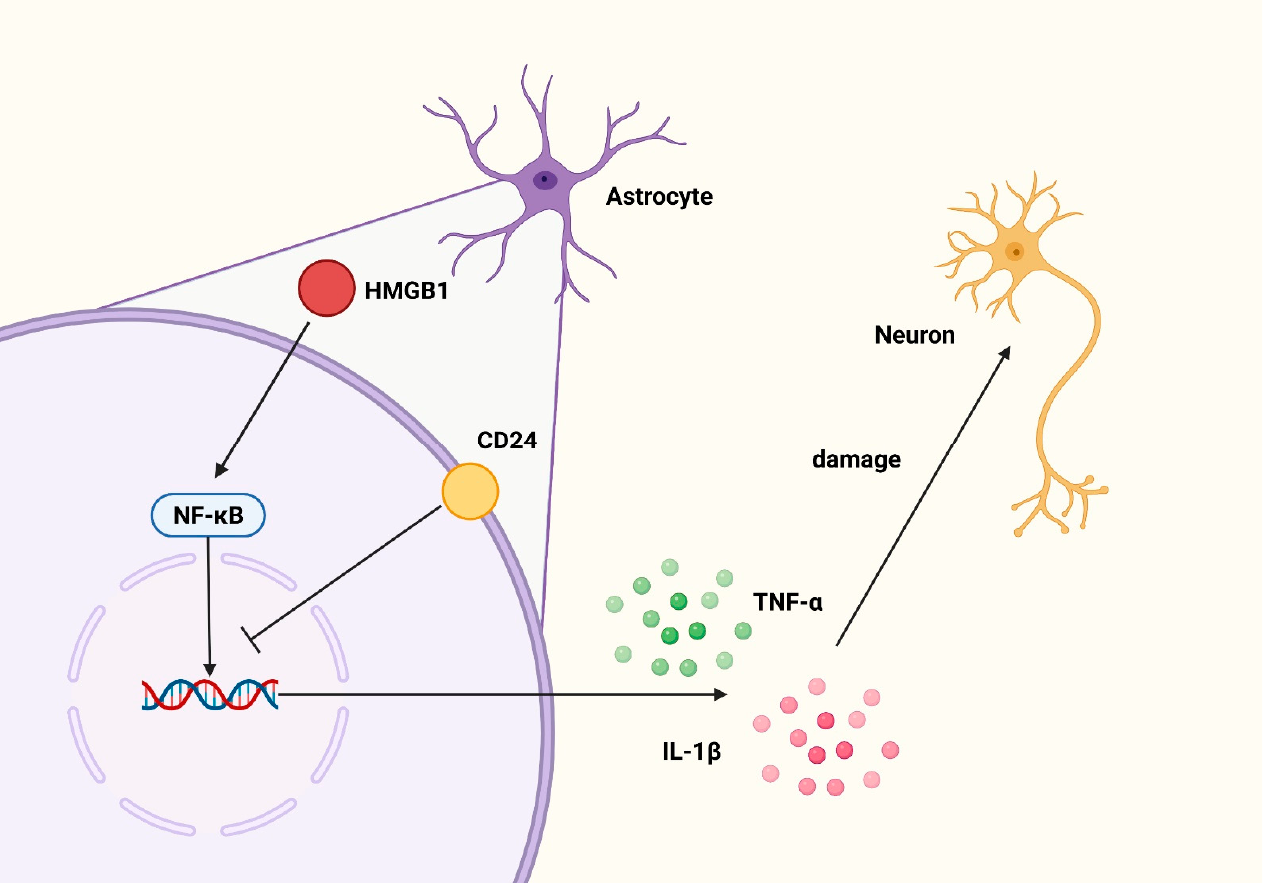
Figure 6. Graphical abstract of the present research. The zoom on the left shows that astrocytes, after being stimulated by HMGB1, will activate the NF- κ B pathway and cause the release of downstream inflammatory factors, such as TNF- α and IL-1 β , thus causing damage to neurons. Meanwhile, CD24 can play an inhibitory role in this process by inhibiting the DNA binding ability of NF- κ B. Figure was created via BioRender.com (accessed on 17 December 2021).